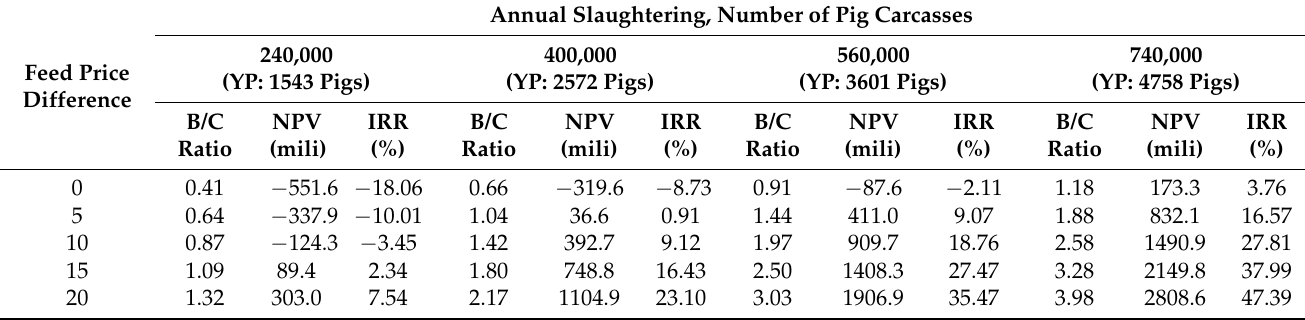
Table 6. Sensitivity analysis according to adjusting feed price difference and slaughter volume change by growth stage.